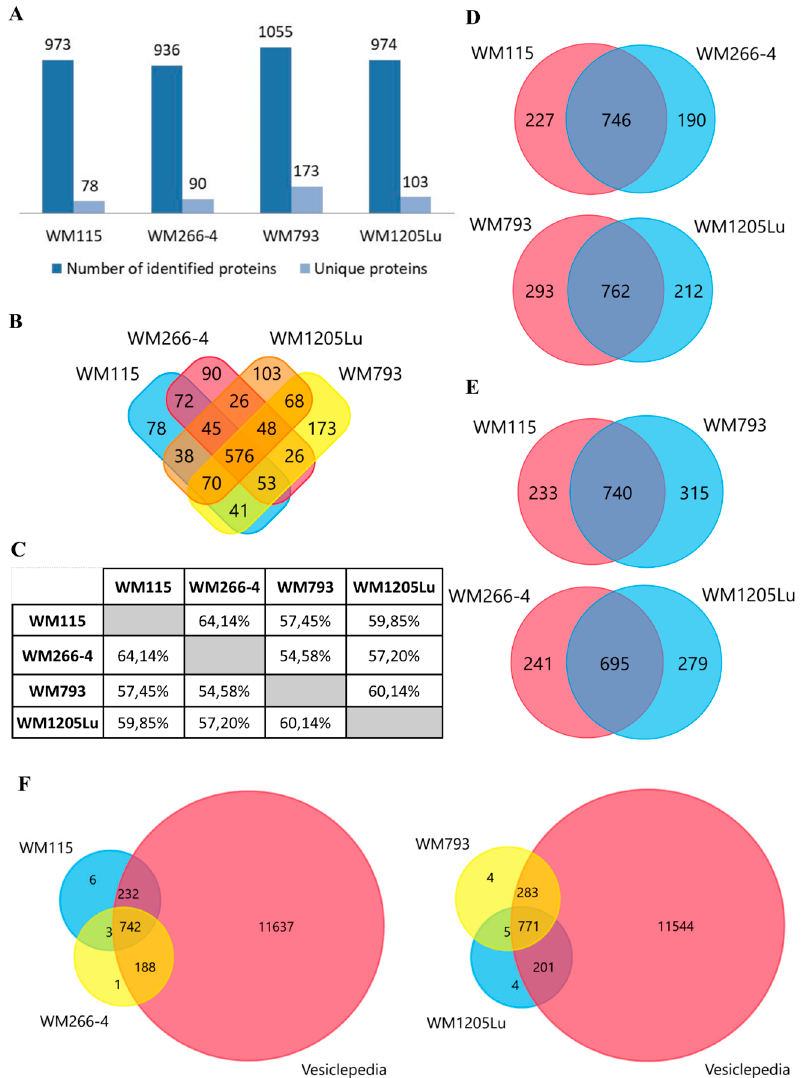
Figure 2. ( A ) Number of proteins identified in two biological replicates of each CM ectosome sample by at least two peptides. ( B ) Venn diagram illustrating the number of proteins shared between given ectosome samples. ( C ) Percentage of proteins shared between given ectosome samples. Venn diagrams illustrating the number of proteins shared between ectosomes released by isogenic ( D ) and primary or metastatic CM cells ( E ). Venn diagram illustrating protein overlap between CM ectosomes and Vesiclepedia database as a reference ( F ). Ectosomes were isolated from WM115 (primary) and